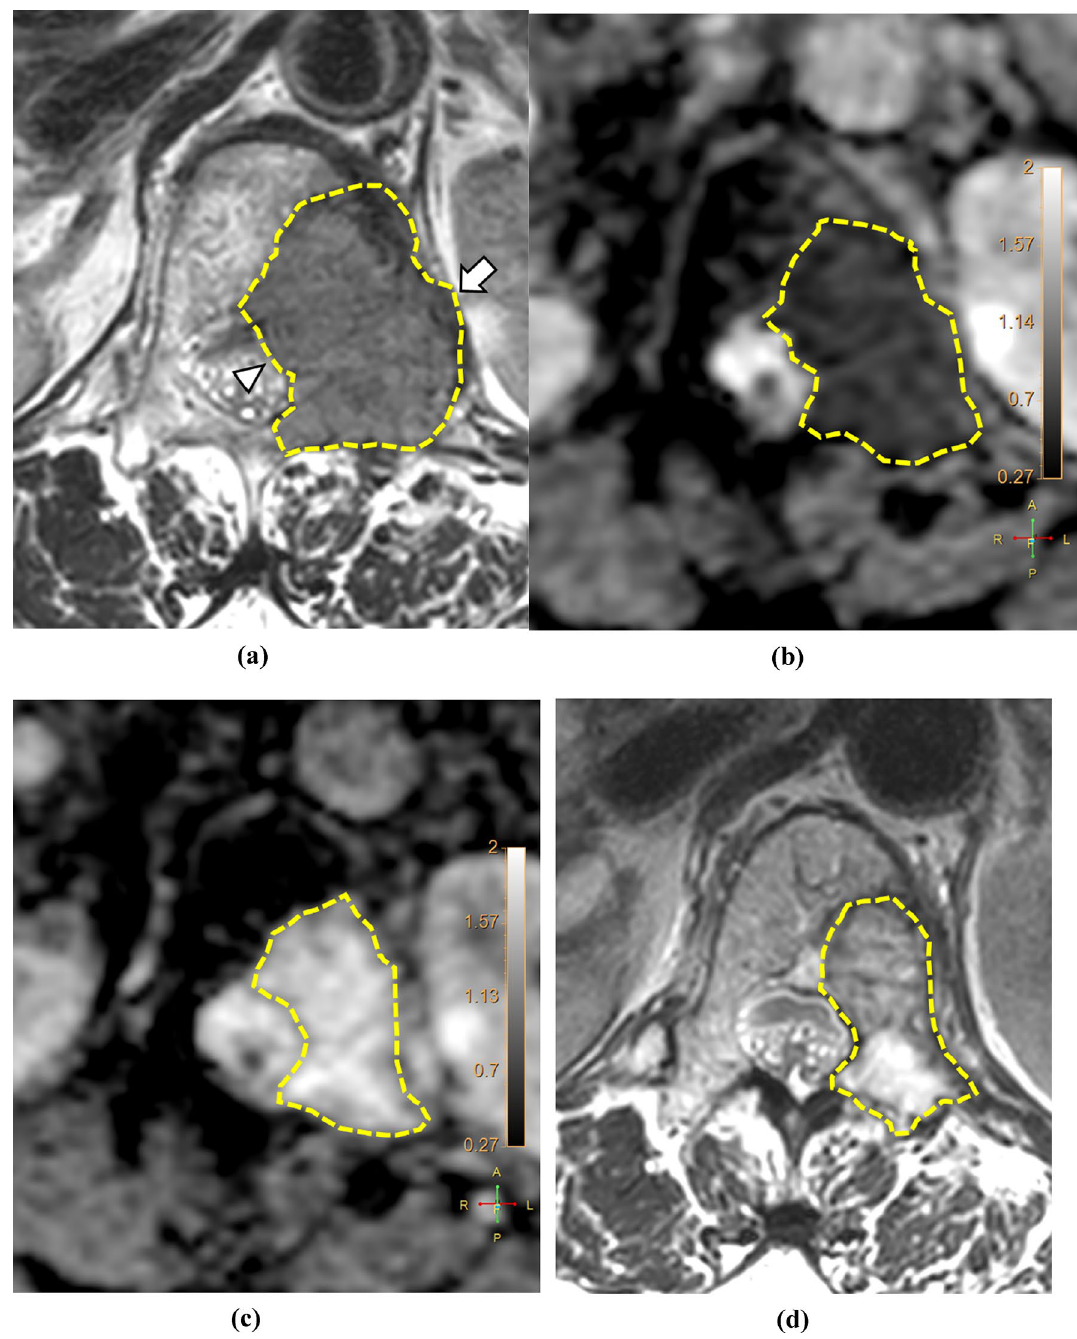
Figure 4. Images of a 71-year-old woman with metastasis to the T12 vertebra from a hepatocellular carcinoma. The tumor margin is delineated by yellow dotted lines. ( a ) The T2WI of the baseline MRI shows a 2.6 × 3.7-cm-sized metastatic lesion with an extraosseous extension to the left paravertebral (arrow) and epidural spaces (arrowhead). Compared with ( b ) the baseline MRI, the average mean ADC value measured by readers I and II in the ( c ) first post-RT MRI increased from 0.68 to 1.39 (× 10 –3 mm 2 /s). ( d ) The T2WI of the second post-RT MRI shows that the size of the lesion decreased to 1.6 × 3.4 cm, representing a partial response. ADC apparent diffusion coefficient, MRI magnetic resonance imaging, RT radiation therapy, T2WI T2-weighted